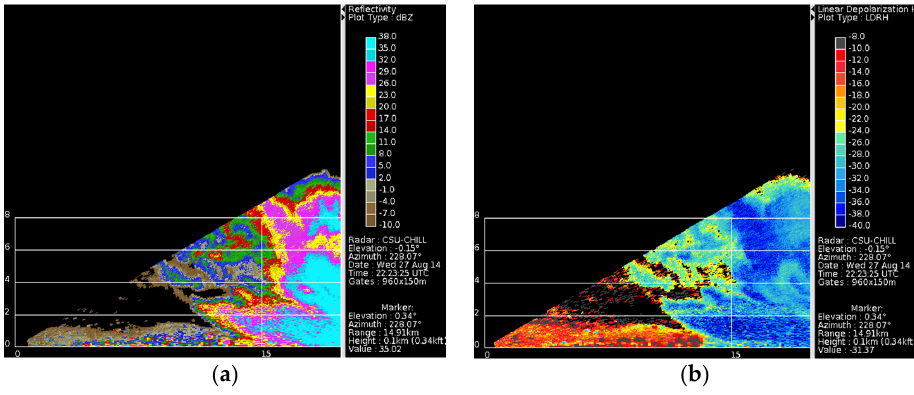
Figure 14. Nesse site (at a range of 14.88 km) as rain approached on 27 August 2014: VCHILL (Virtual CHILL) displays of ( a ) Z e and ( b ) LDR measured by CSU-CHILL Radar. LDR “wedge” is apparent, due to the University of Northern Colorado/Greeley hill, downrange; it fades out as precipitation echo strength exceeds about 25 dBZ.